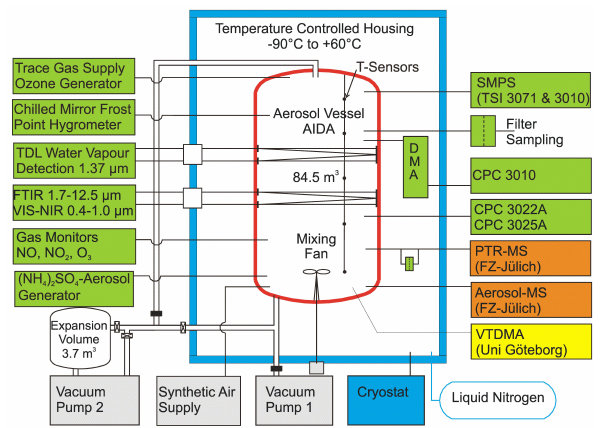
Fig. 1. AIDA chamber with instrumentation. For this study data provided by a Scanning Mobility Particle Sizer (SMPS), a Proton- Transfer-Reaction-Mass Spectrometer (PTR-MS), and an Aerosol Mass Spectrometer (AMS) were used. Further supporting instru- ments were condensational particle counters (CPC), a differential mobility analyzer (DMA), a tuneable diode laser system (TDL), a fourier transform infrared (FTIR) spectrometer, a volatility tandem mobility analyzer (VTDMA) and a frost point mirror hygrometer as well as gas monitors for NO, NO 2 and O 3 . The temperature in the chamber was varied between 243K and